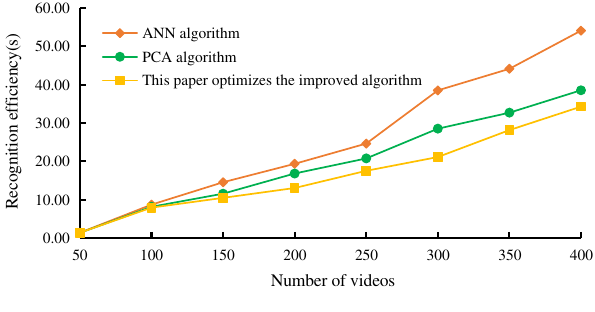
Comparative analysis of recognition efficiency of three